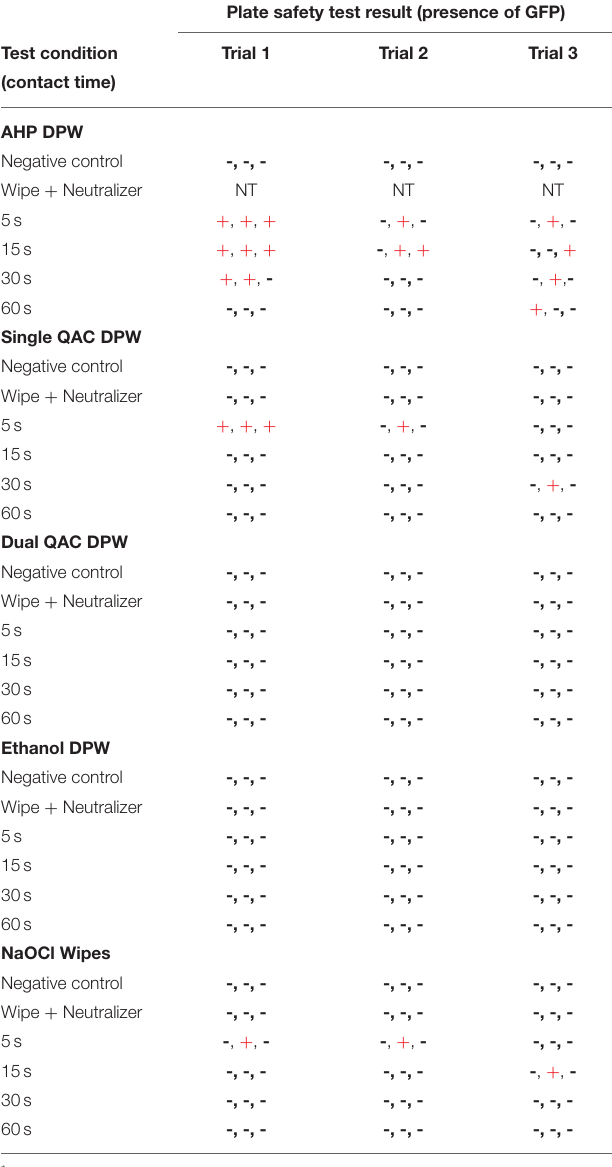
TABLE 2 | Plate safety test results for inactivation of EBOV by DPW vs. DMEM-impregnated J-Cloth wipes *